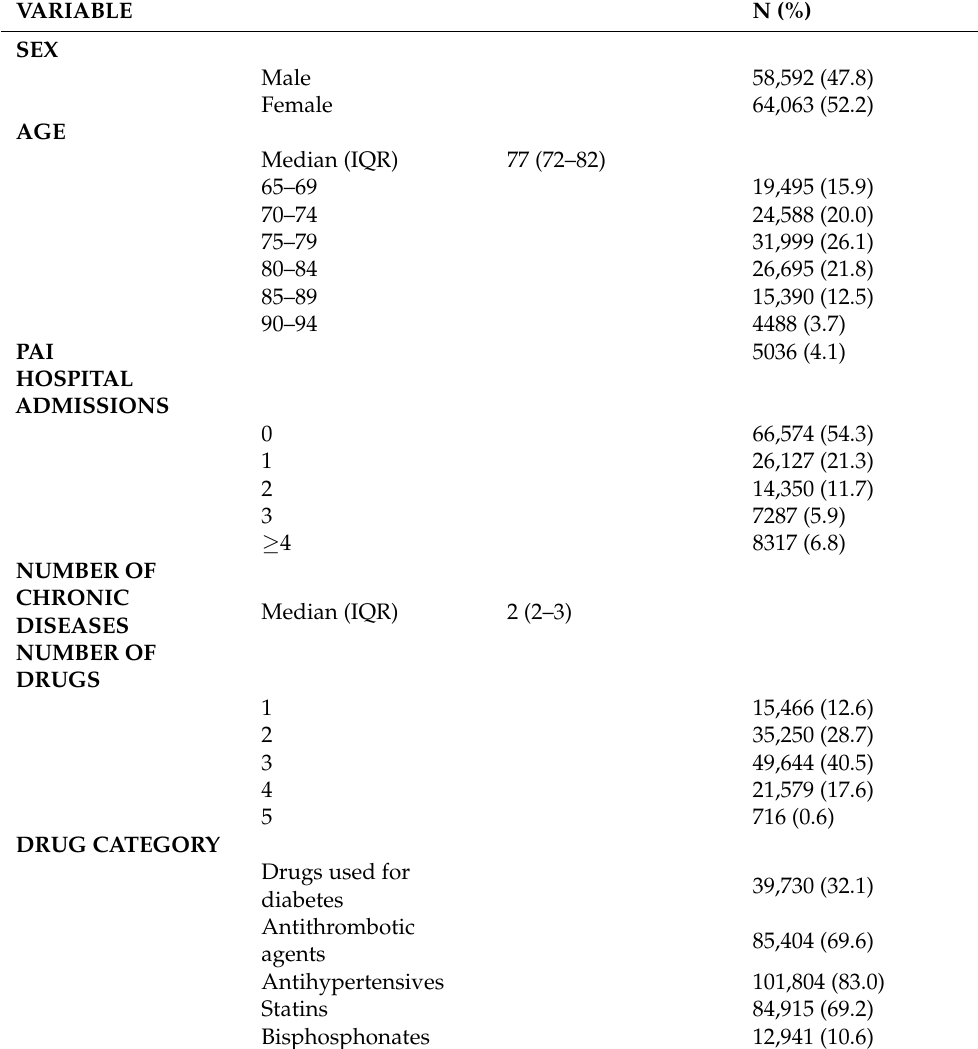
Table 1. Patients’